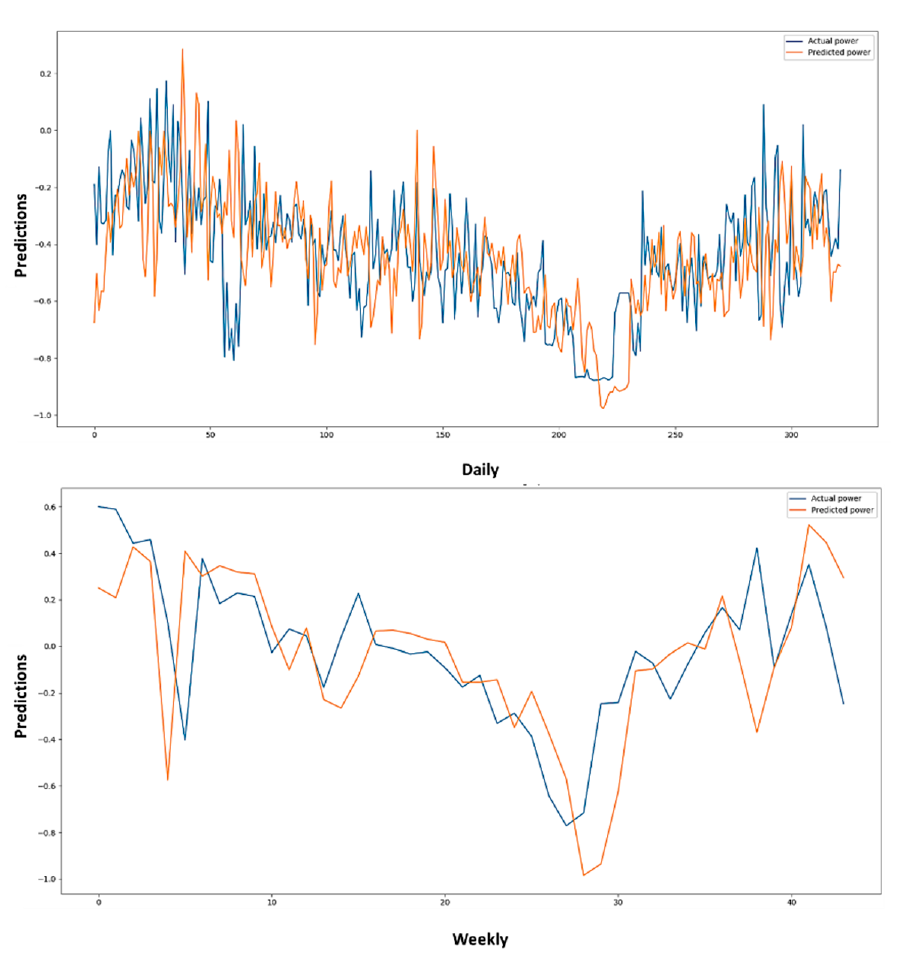
Figure 9. Graphical representation of the prediction of energy based on actual data used. The prediction was obtained using the proposed method M-LSTM on different resolutions such as minutes and hours.